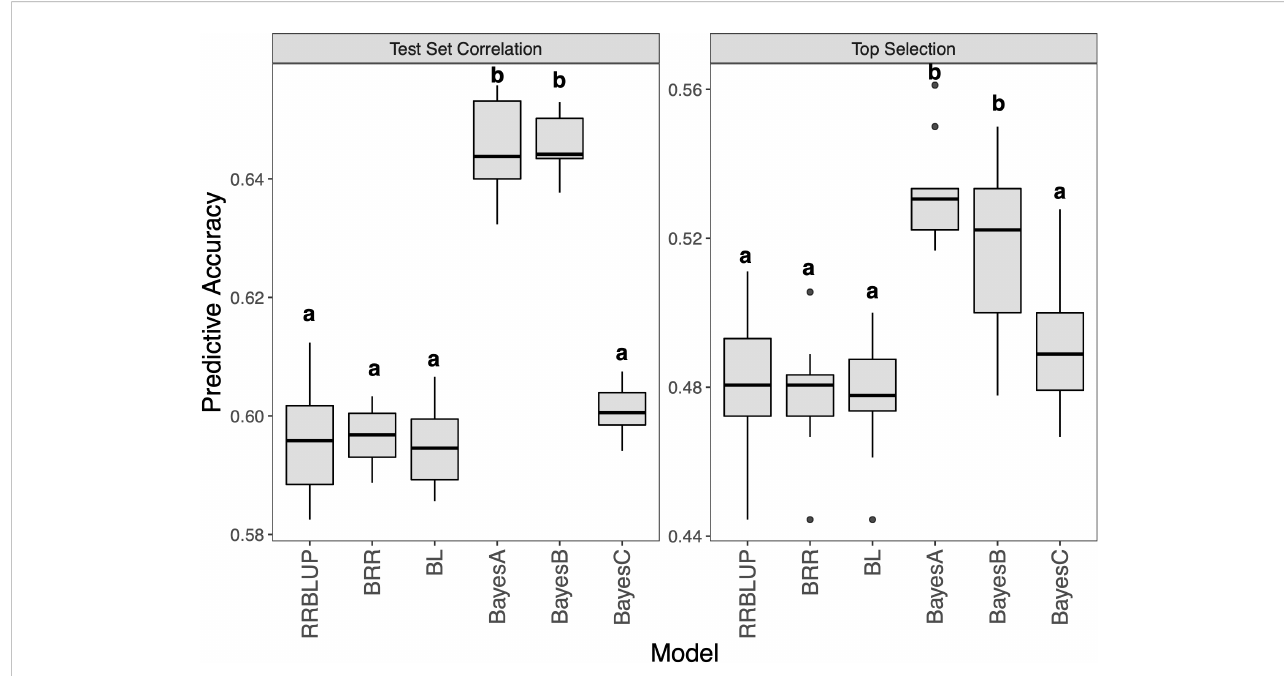
FIGURE 6 Genomic prediction study in hybrid panel with maker based models for Southern Corn Rust (SCR) resistance. The left is prediction accuracy for test set and the right is accuracy for top